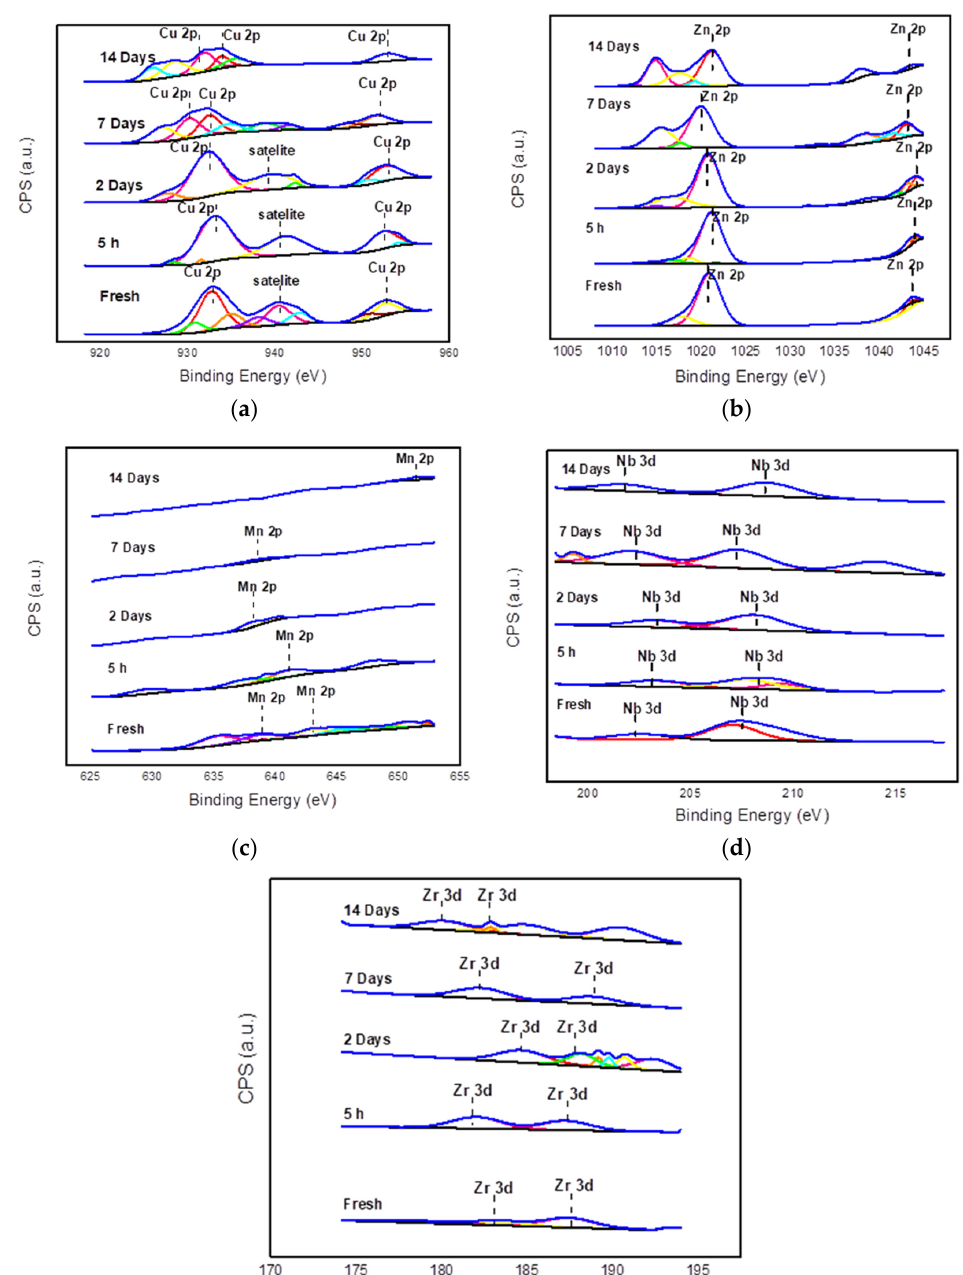
Figure 5. XPS spectra for ( a ) Cu 2p ( b ) Zn 2p ( c ) Mn 2p ( d ) Nb 3d and ( e ) Zr 3d . Table 7. Binding energy for each element.